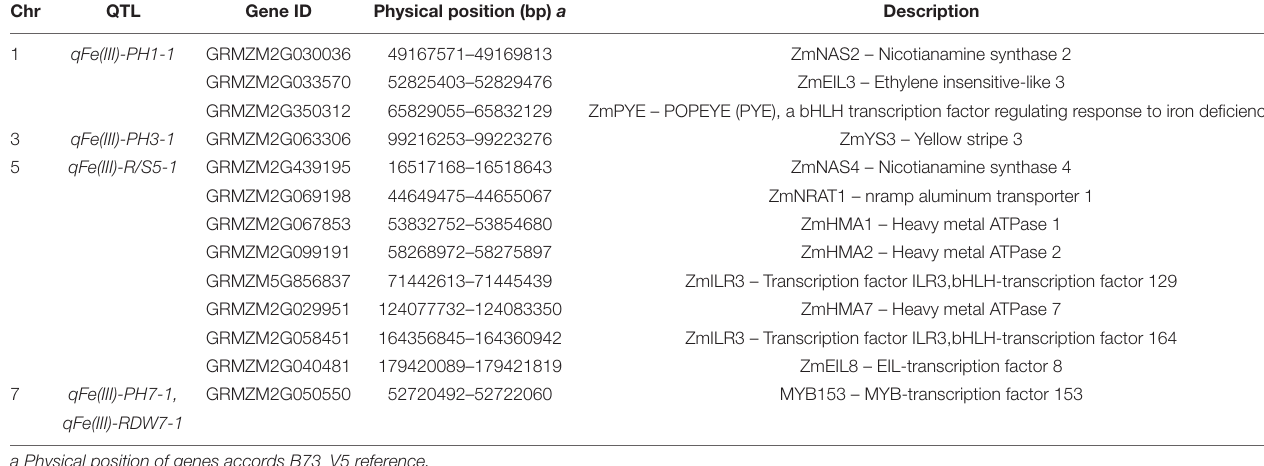
TABLE 4 | Candidate genes associated with Fe deficiency tolerance in maize.